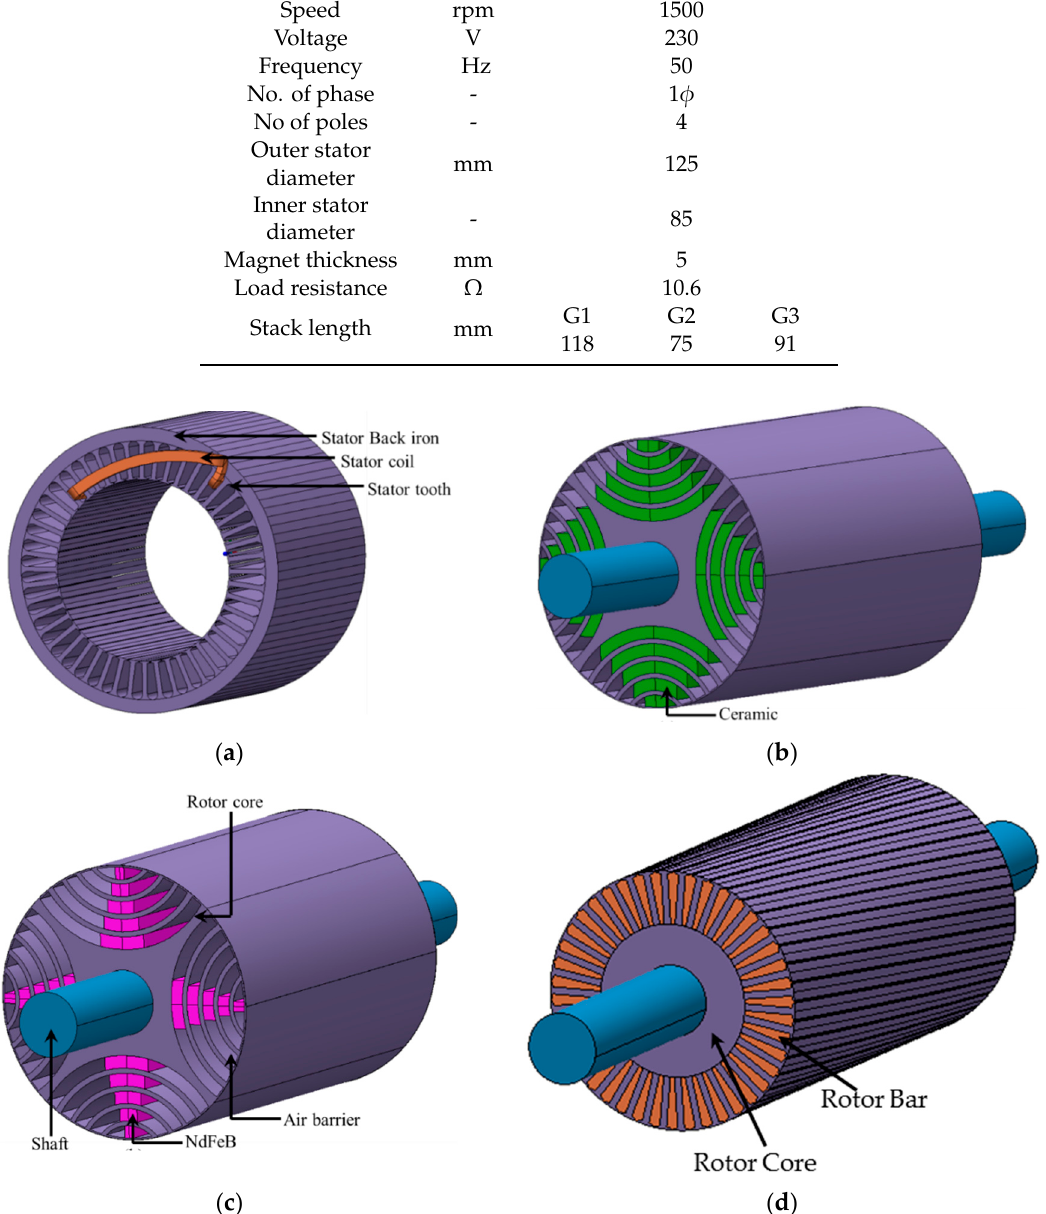
Figure 4. SynRG with: ( a ) stator, ( b ) ferrite rotor, (G1), ( c ) NdFeB rotor (G2), ( d ) IG (G3).